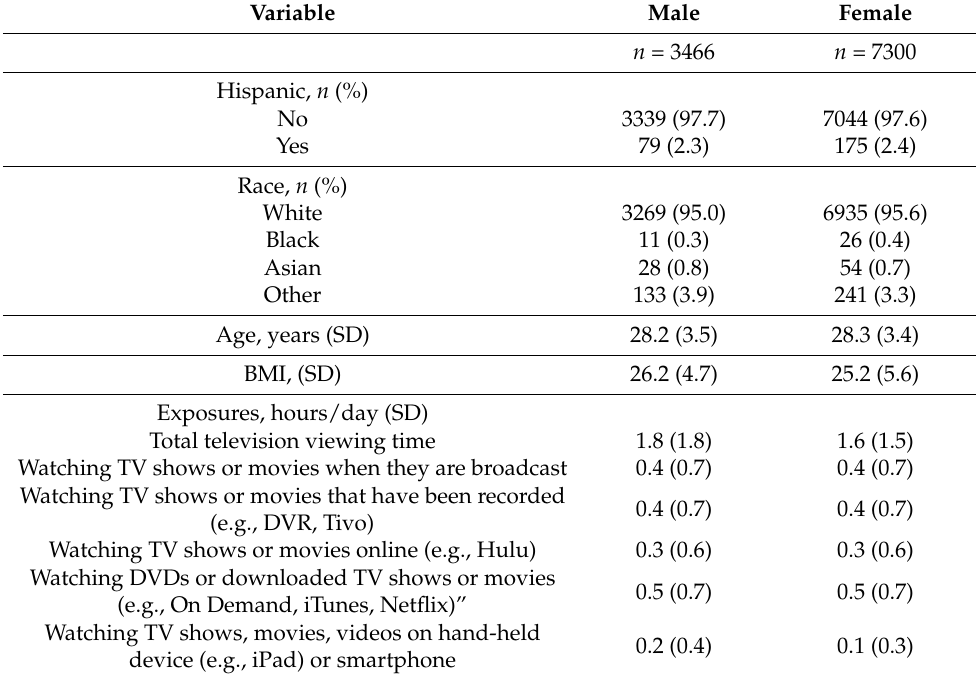
Table 1. Participant characteristics according to sex ( n =